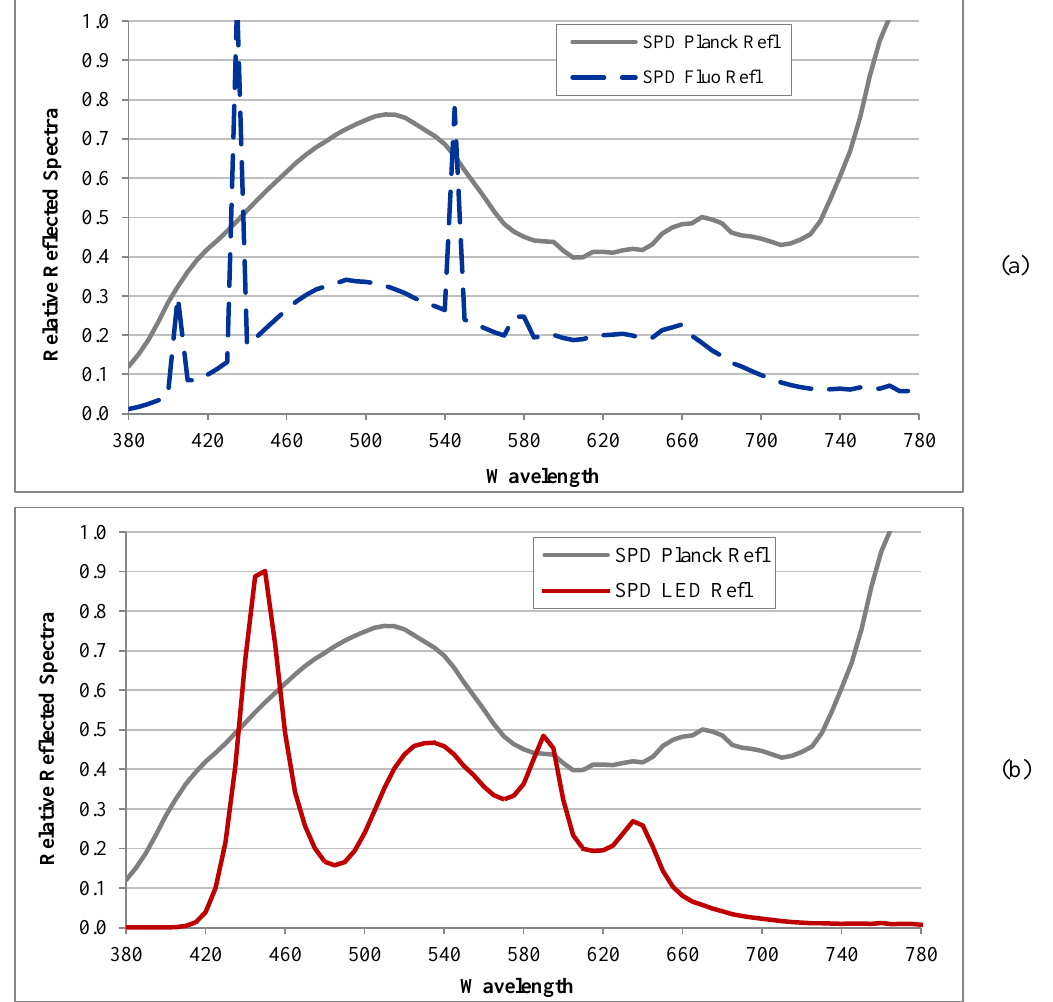
Figure 3. SPDs of reflected light from the body of the Smurf figurine: (a) Comparing the results of the 4000 K Fluorescent source and 4000 K Planckian radiator; (b) Comparing the results of the 4000 K LED-combination source and 4000 K Planckian